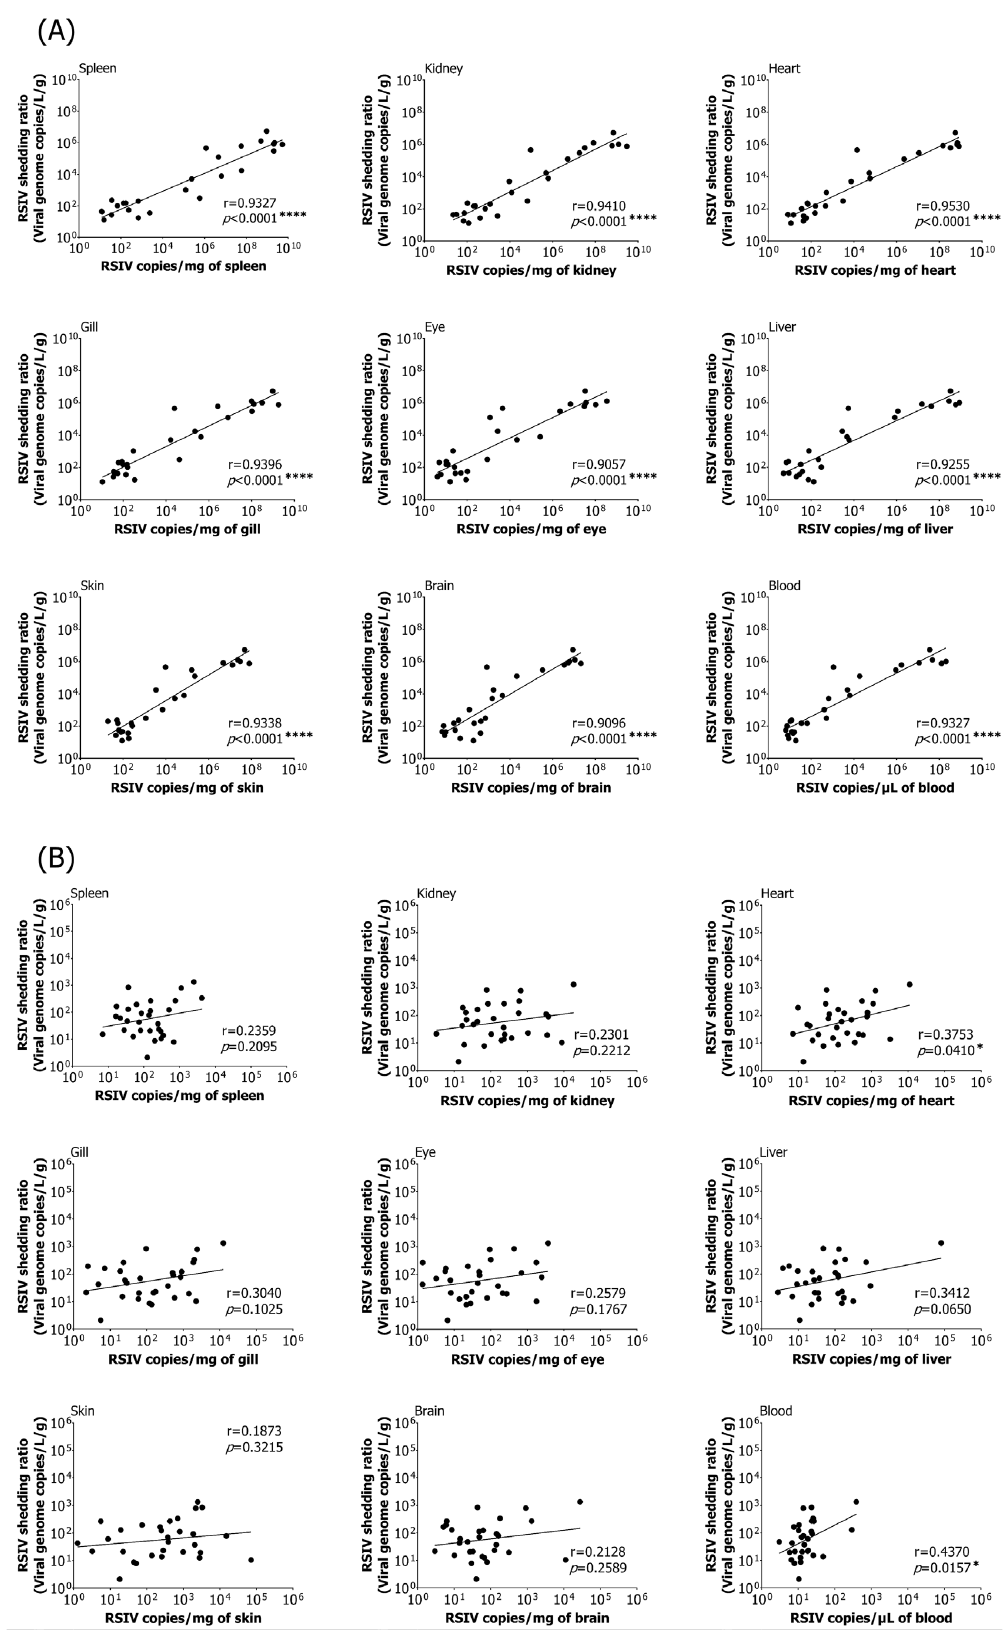
Figure 3. A correlation analysis was performed to examine the association between the viral load in nine different tissues (spleen, kidney, heart, gills, eyes, liver, skin, brain, and blood) and the red sea